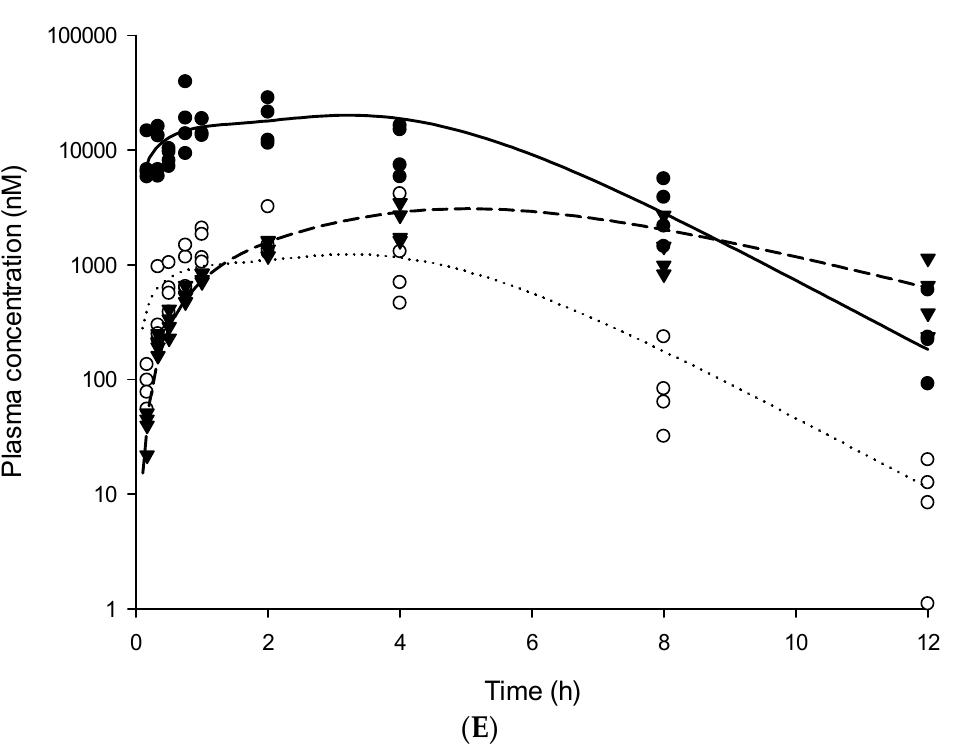
Figure 4. Predicted plasma concentration-time plot of Lidocaine (solid line, ● ), MEGX (do tt ed line, ▼ ), and GX (dashed line, ○ ) with observed data after SC administration of 0.3% lidocaine solution IV ( A ), 0.3% lidocaine solution SC ( B ), 0.3% LHA ( C ), 1% LHA ( D ), or 3% LHA ( E ).